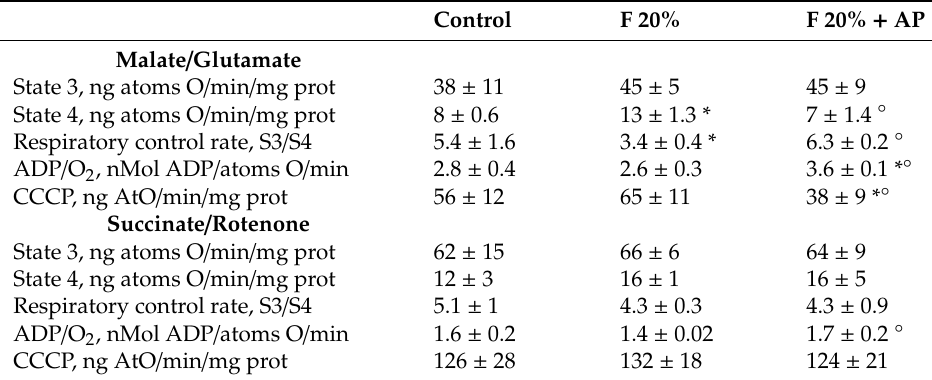
Table 2. Mitochondrial respirometry in fasted rats.